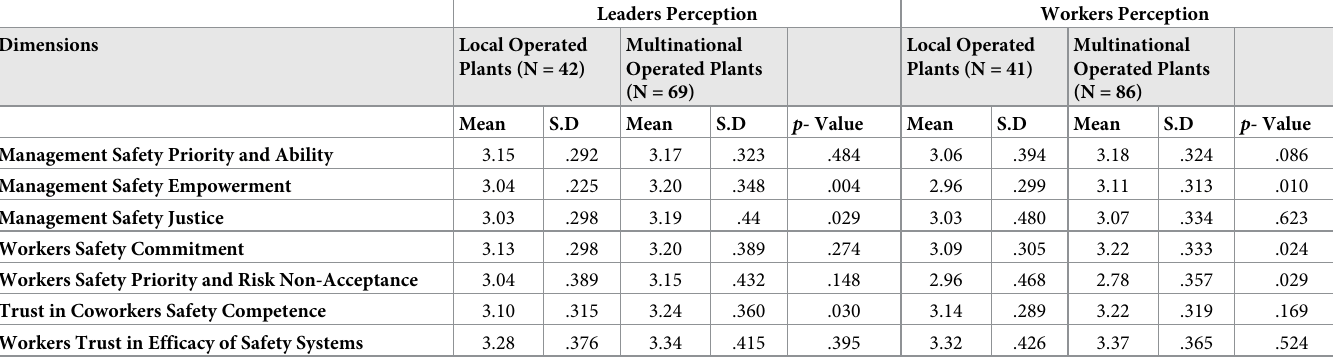
Table 4. Safety climate comparison between local & multinational employers leaders & workers